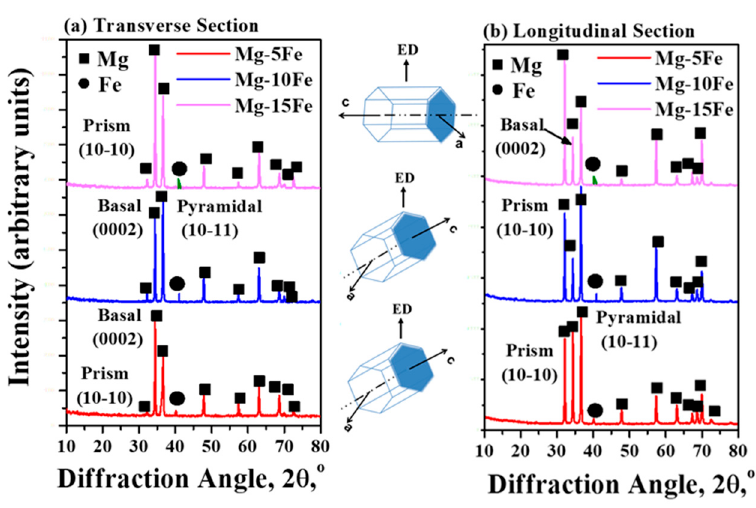
Figure 2. X-ray diffraction patterns of Mg-Fe composites along ( a ) transverse and ( b ) longitudinal sections.